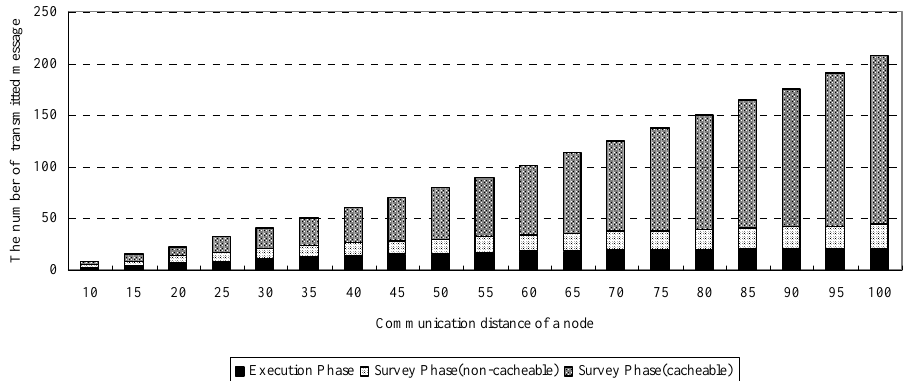
Figure 7. The average number of message exchanges of a node for clustering a network.